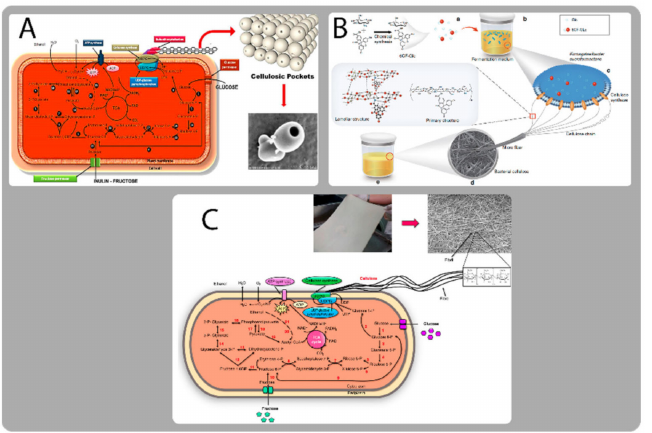
Figure 6. Visualization of various biosynthesis paths of bacterial cellulose. ( A ) Bacterial cellulosic (BC) pocket synthesis mechanism reported by Narh et. al. [138]. ( B ) Synthesis of 6CF-BC based on an in situ microbial fermentation method reported by Gao and co. [139]. ( C ) Pathways for the biosynthesis of BC by K. xylinus and the assembly of cellulose molecules into nanofibrils reported by Jacek et al.